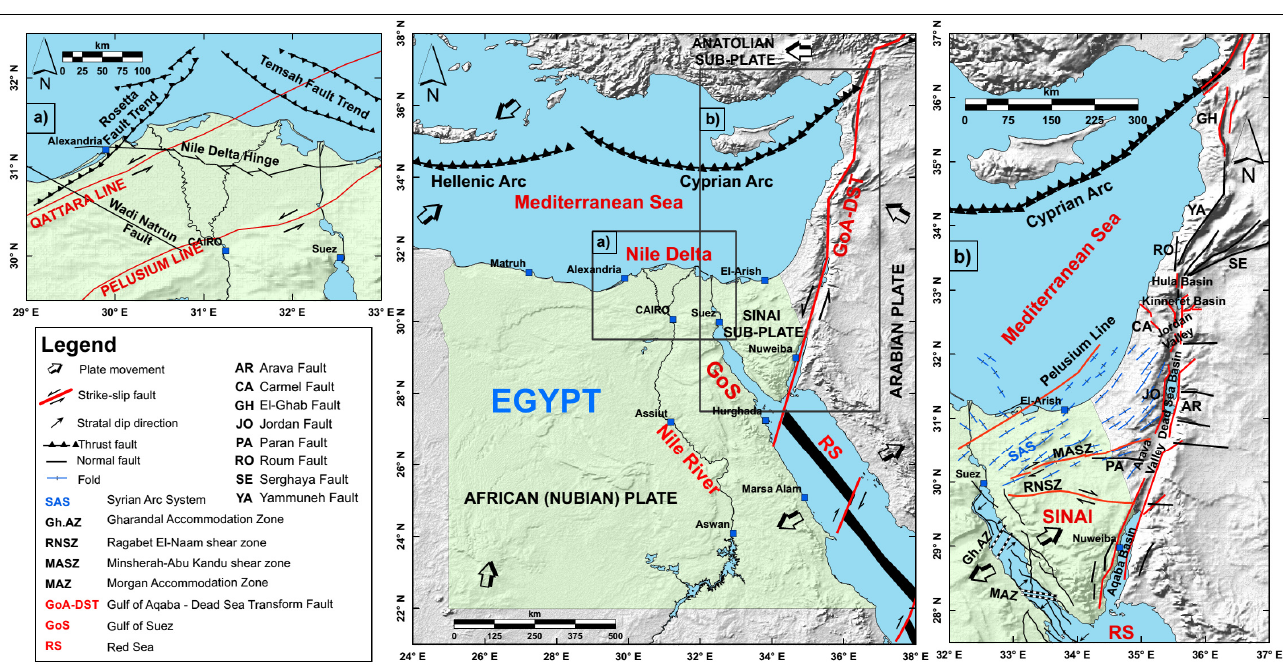
Figure 1. Compiled global tectonic sketch for Egypt and its surrounding regions (the middle plot: after [43]), the Nile Delta region (the left plot ( a ): after [44]), and the Sinai Peninsula and the Dead Sea regions (the right plot ( b ): after [45–47]). Abbreviations for the geographic features, faults, and shear zones are included in the legend.